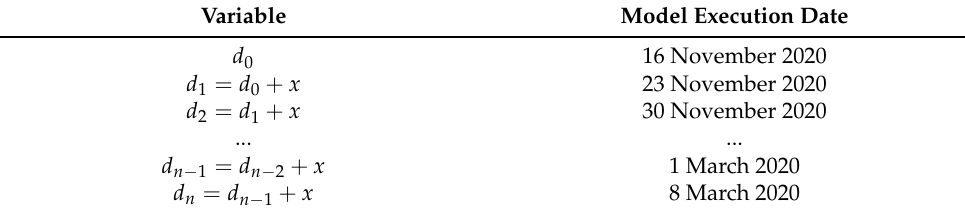
Table 1. Periodic forecasting of dataset and model